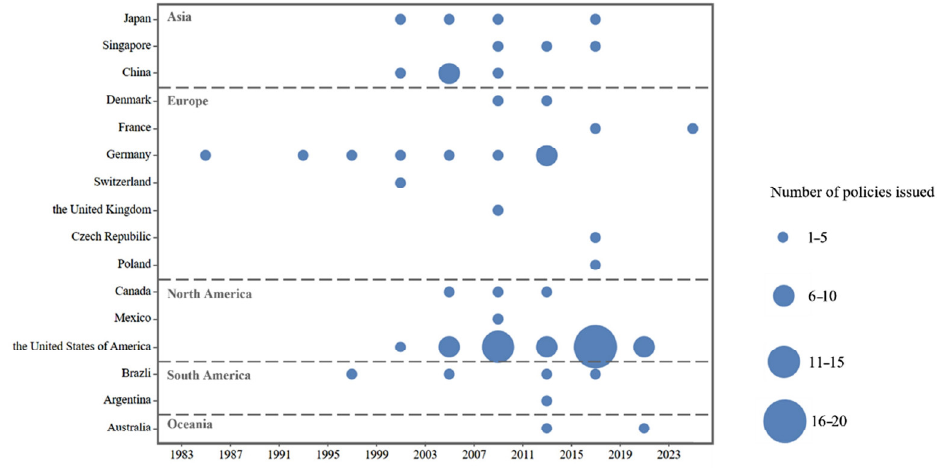
Figure 10. Spatial and temporal distribution of green roof incentive